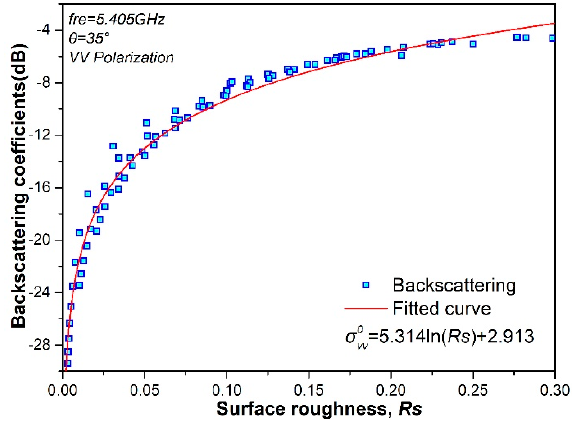
Figure 5. Backscattering coefficients (dB) simulation in the VV polarization at 35° incidence, presented using blue blocks. The red line represents the fitted curve.